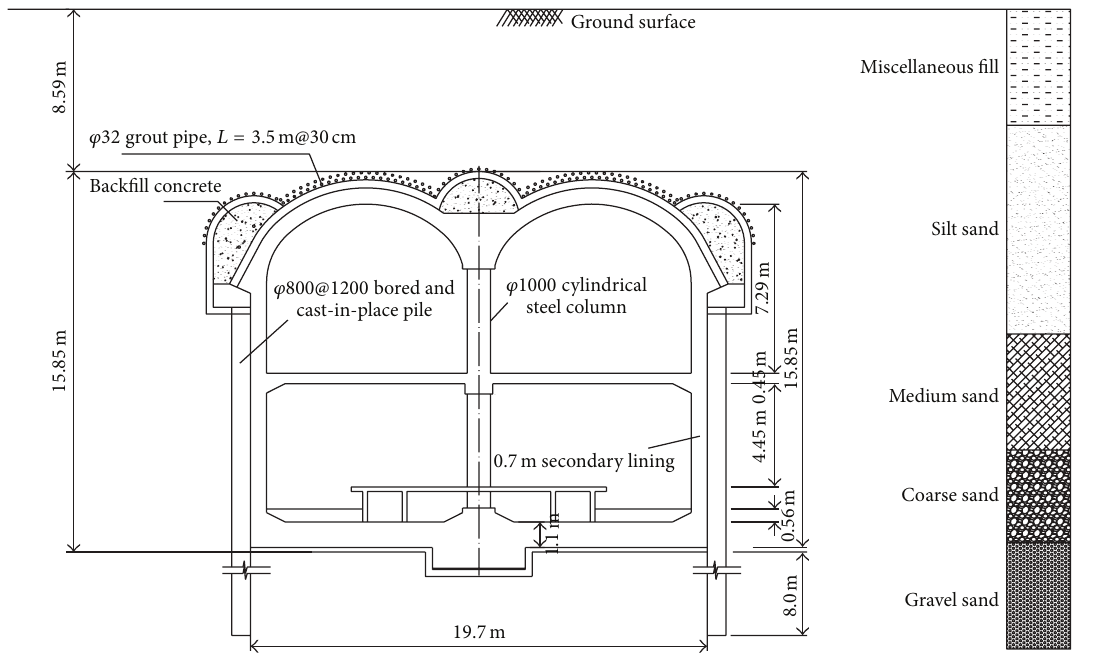
Figure 2: Typical cross section of Zhongjie subway station.